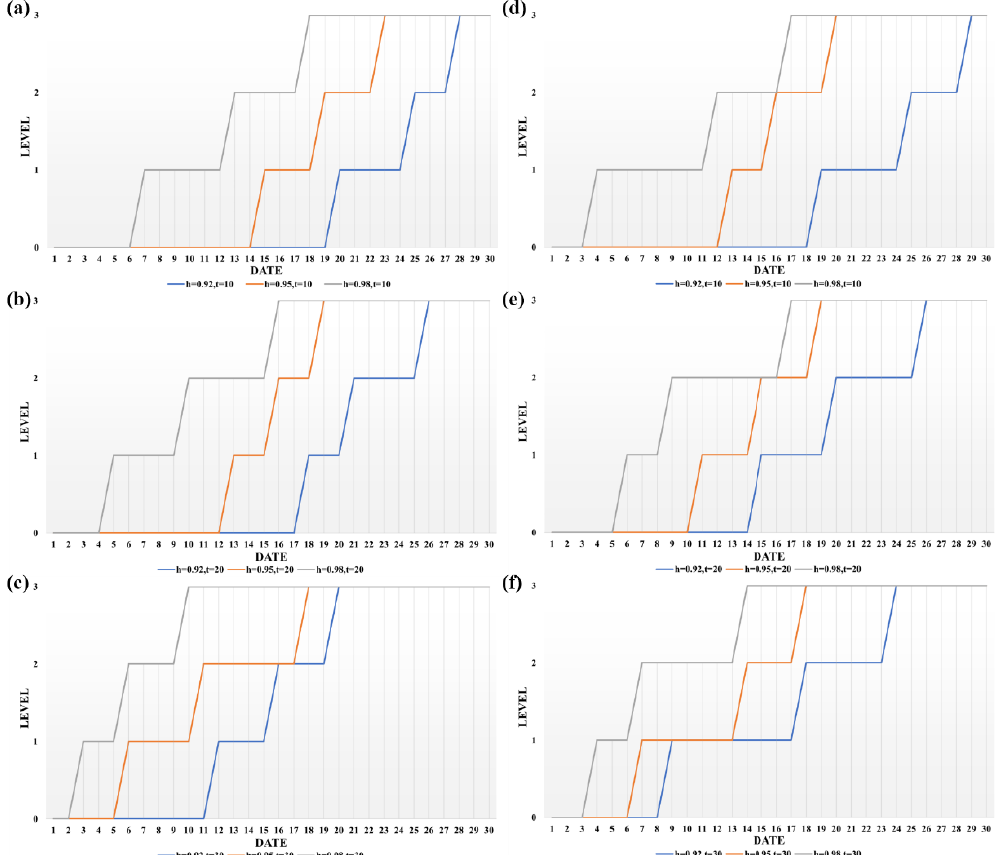
Figure 7. Folding line graph of the quality grade of aflatoxin and vomitoxin in paddy grains with different storage conditions. ( a – c ) are the line graphs of the quality grade of aflatoxin with time at 0.92, 0.95, and 0.98 water activity at 10 °C, 20 °C, and 30 °C, respectively. ( d – f ) are line graphs of vomitoxin quality grade over time at 0.92, 0.95, and 0.98 water activity at 10 °C, 20 °C, and 30 °C, respectively.